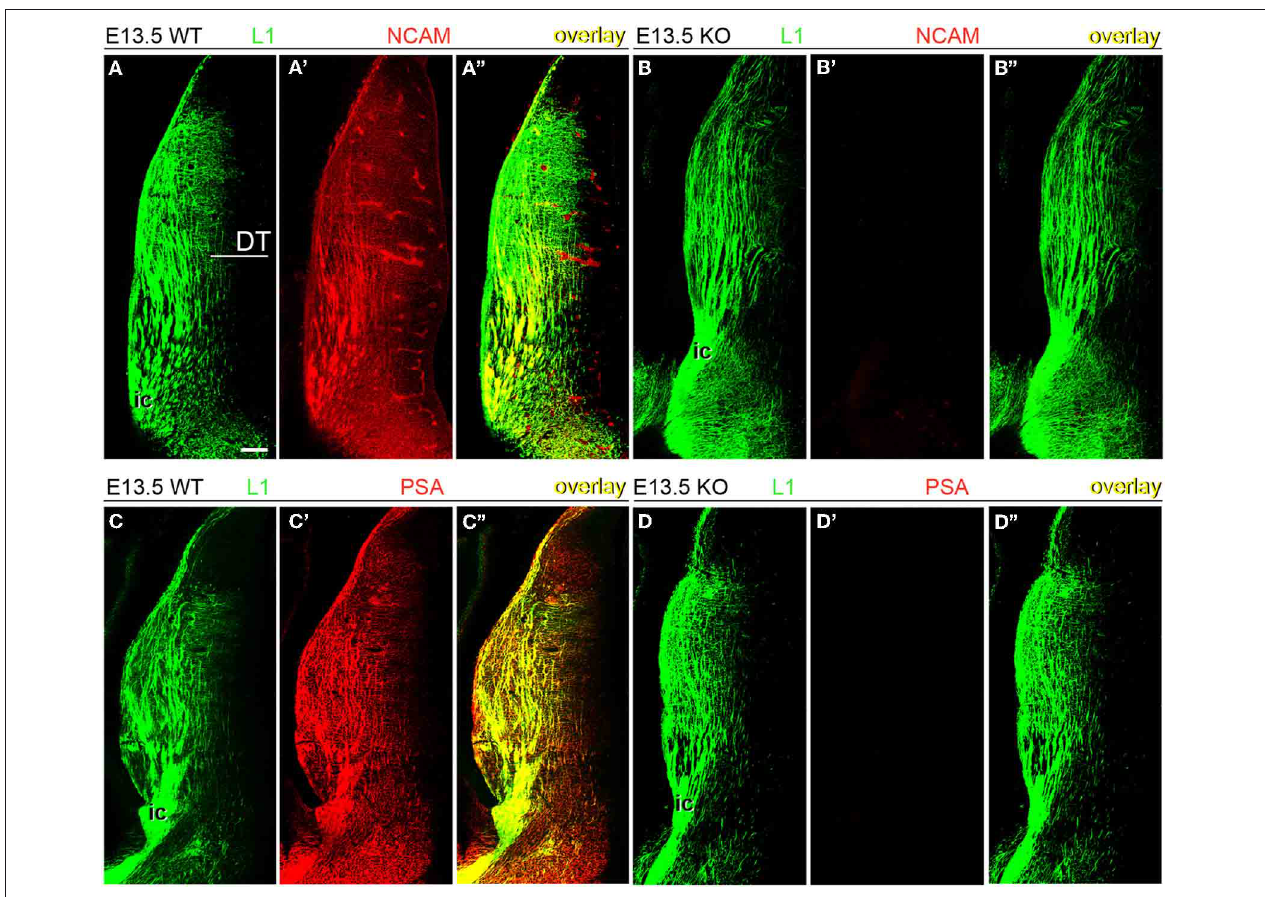
thalamus of wild type mice (C) but absent in NCAM null mice (D) , suggesting that PSA is linked to NCAM in these axons. L1-immunoreactive TC axons formed descending fascicles that converged into the caudal limb of the internal capsule (ic) leading through the ventral telencephalon to the developing cortex. Single confocal optical sections. DT, dorsal thalamus; ic, internal capsule. Bar (in A ): 100 μ